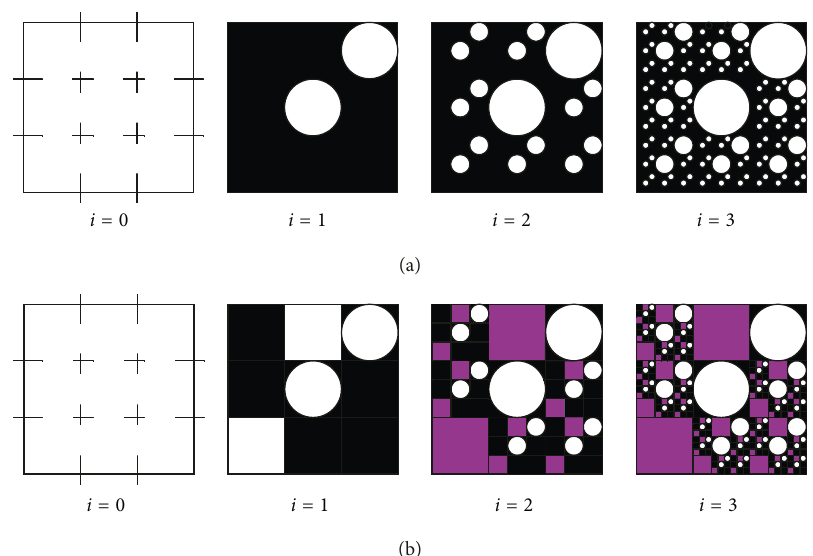
Figure 1: Sierpinski carpet construction: (a) geometric construction of the Sierpinski carpet and its iteration process. The fractal dimension D f is 1.77 and the iterations are 3. (b) Fractal scaling ( i � 0, 1, 2, and 3) for the Sierpinski carpet with two pores at first iteration. Starting from second iteration, two squares remain solid forever and five squares generate new